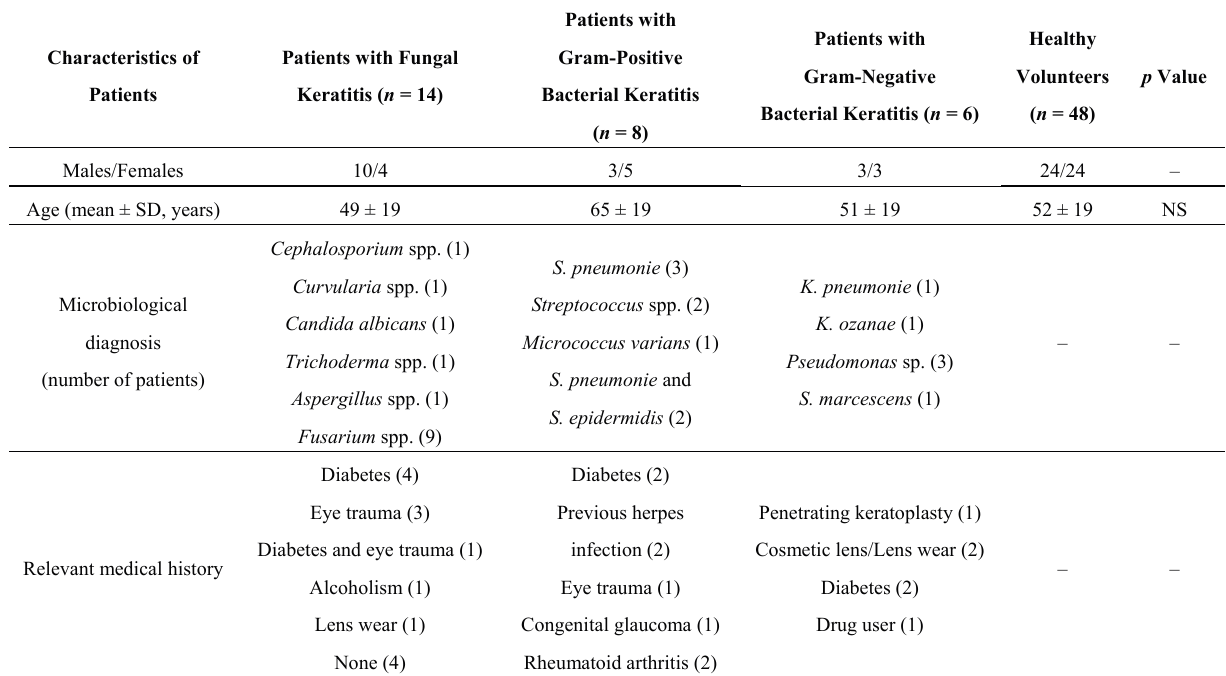
Table 1. Demographics and relevant medical history of patients with microbial